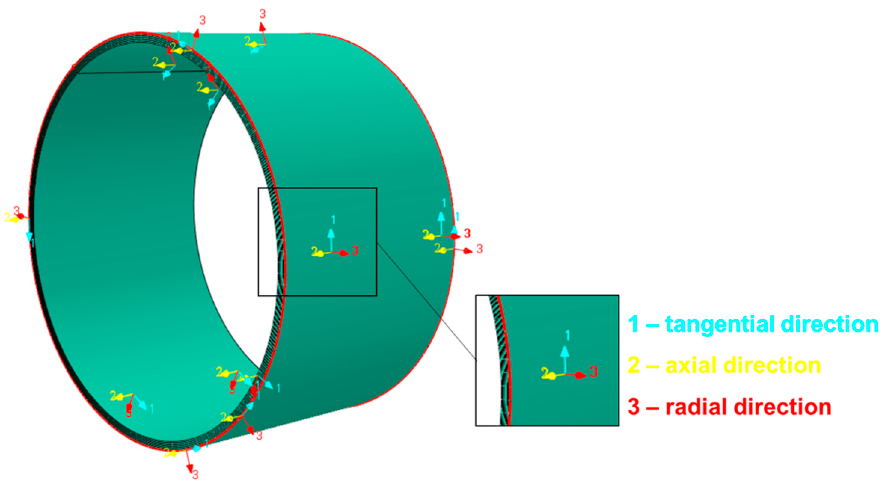
Figure 5. CAD model of the different layers of the composite sleeve with a highlight of the local coordinate systems.